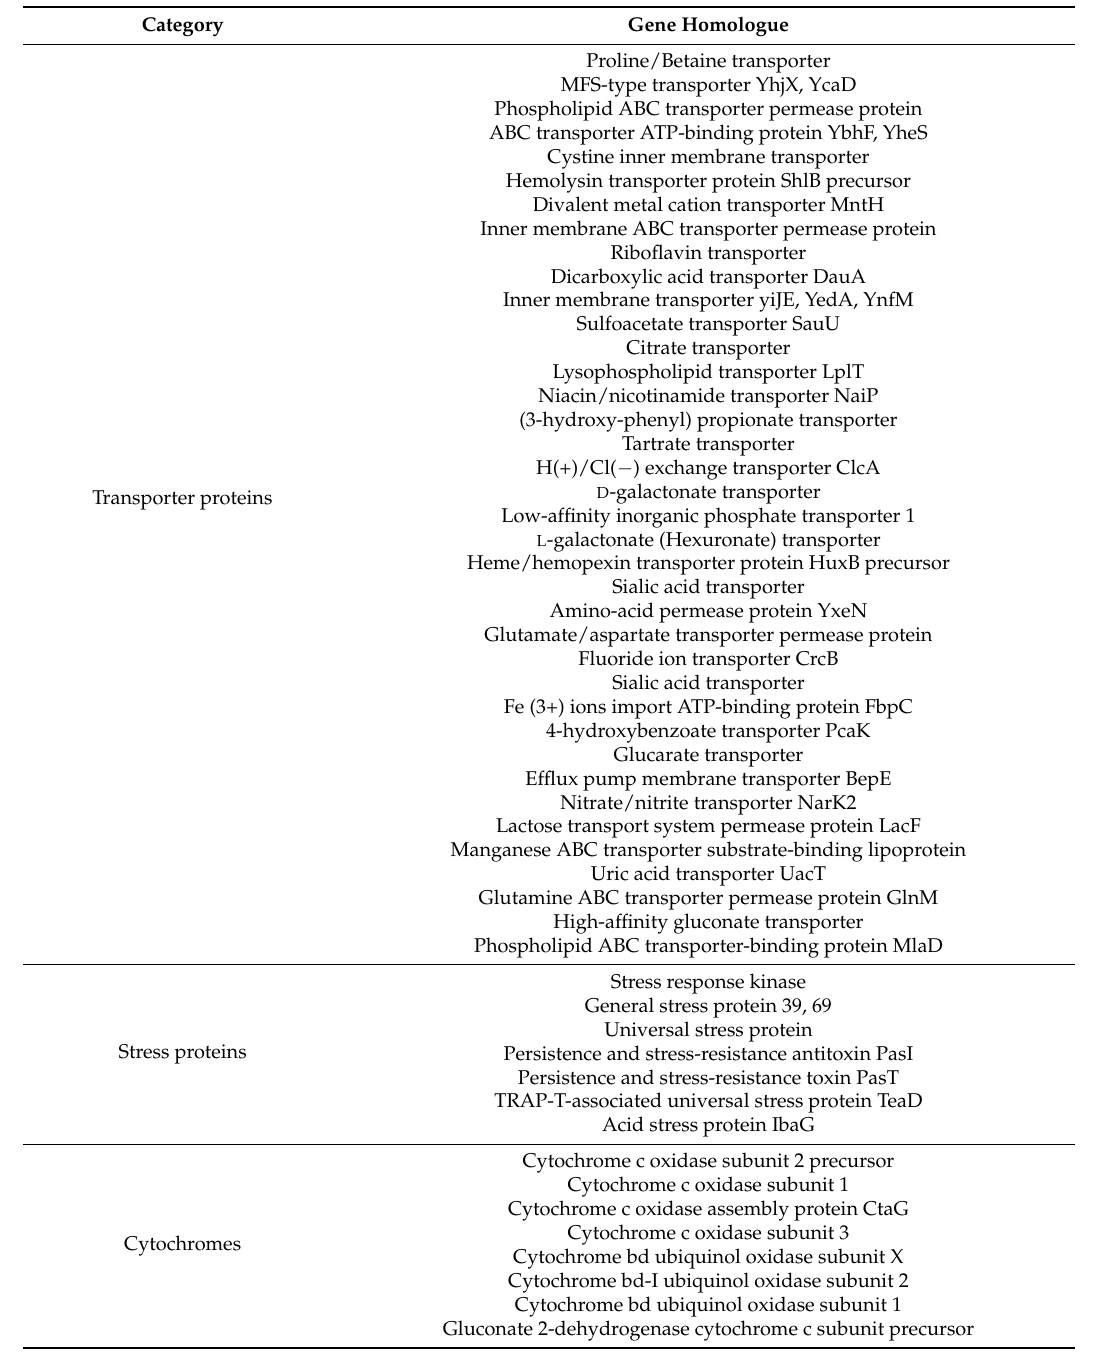
Table 1. Shown are the EDGAR identified core set of gene homologues common between Burkholderia sp. strain SRS-25, strain SRS-46 and SRS-W-2-2016 that likely perform a biodegradative or metal resistance